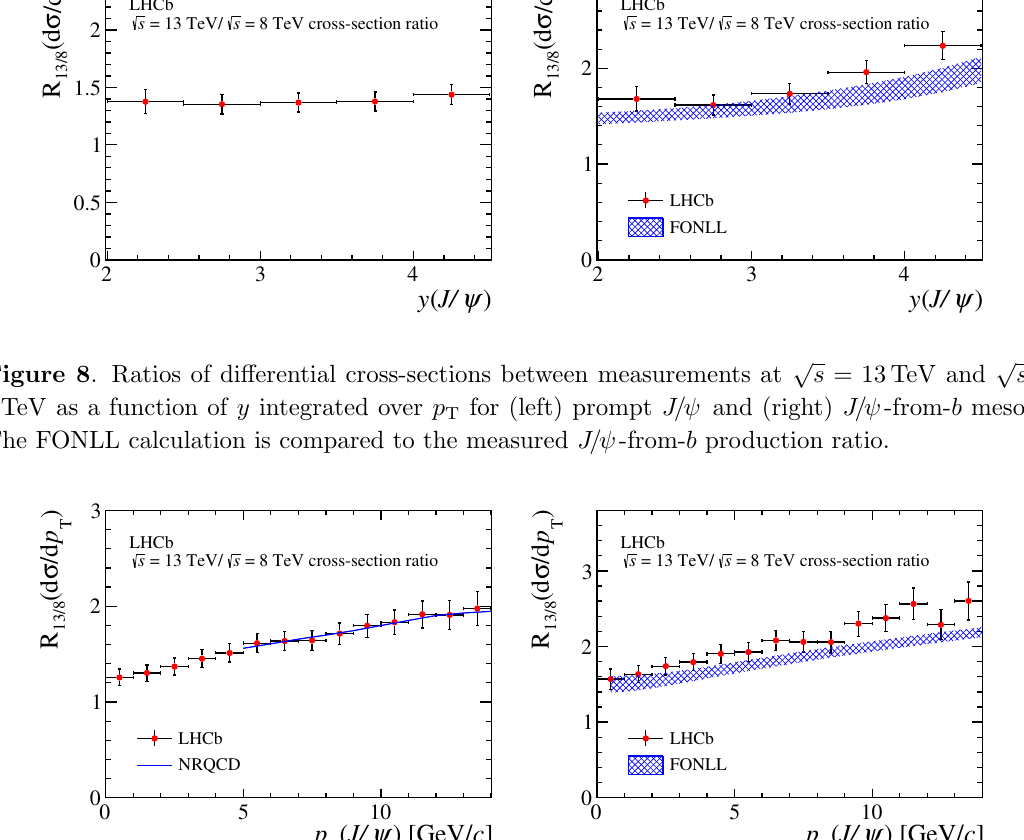
Figure 9 . Ratios of di(cid:11)erential cross-sections between measurements at 8 TeV as a function of p T integrated over y for (left) prompt J= mesons and (right) J= -from- b mesons. Calculations of NRQCD and FONLL are compared to prompt J= mesons and J= -from- b mesons, respectively.